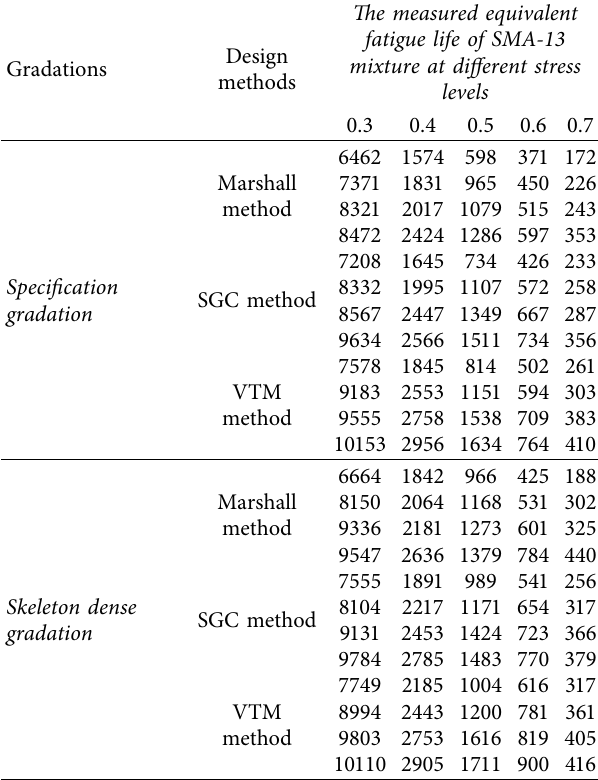
Table 9: Measured equivalent fatigue life of the SMA-13 mixture with different gradations and compaction